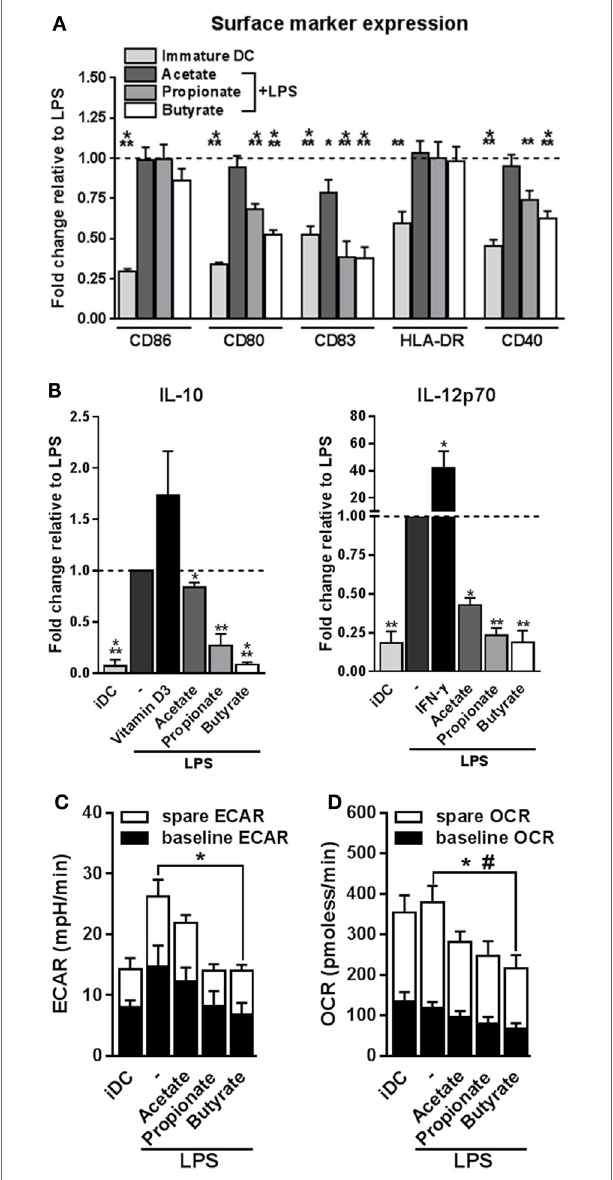
FigUre 1 | Butyrate suppresses LPS-induced activation and metabolic changes in human dendritic cells (DCs). (a,B) Monocyte-derived DCs were left untreated (iDC) or stimulated as indicated for 48 h after which (a) expression of maturation markers was analyzed by flow cytometry and (B) supernatants were collected and concentrations of indicated cytokines were determined by ELISA. (a) The expression levels of maturation markers are based on the geometric mean fluorescence and are shown relative to DCs stimulated with LPS, which was set to 1 for each marker (dashed line). (B) Vitamin D3 and IFN- γ -stimulated DCs were taken along as IL-10- and IL-12-inducing controls, respectively. (c,D) Metabolic phenotype of differently stimulated DCs was assed using a Seahorse extracellular flux analyzer. (c) Baseline and spare extracellular acidification rate (ECAR) were determined as described in Section “Materials and Methods,” with significant differences in baseline ECAR indicated with *. (D) Baseline and spare mitochondrial oxygen consumption rate (OCR) were determined as described in Section “Materials and Methods,” with significant differences in baseline or spare OCR indicated with * and # , respectively. (a–D) Bar graphs represent means ± SEM of at least five experiments. * ,# p < 0.05, ** p < 0.01, *** p < 0.001 based on paired Student’s t